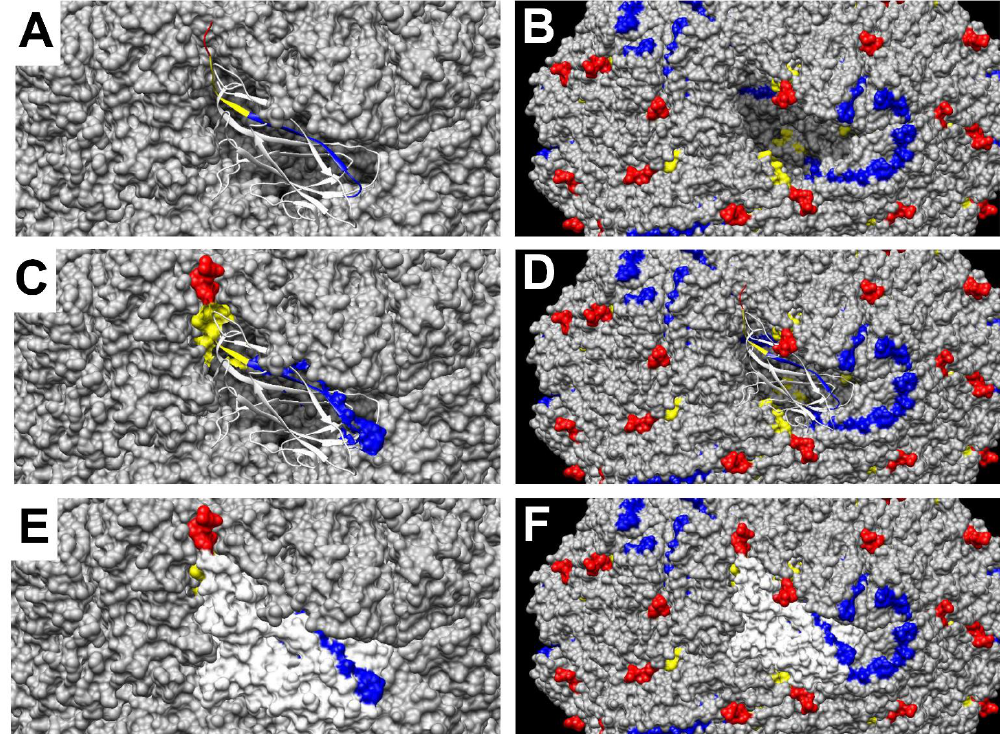
Figure 3. Location of amino acid residues of designed peptide (P64) and critical binding residues on the capsid protein of PCV2a. ( A ) The secondary structures of the single capsid protein of PCV2a were represented as a ribbon diagram in one VLP of PCV2a. The residues 228 – 231 were highlighted in red, the residues 220 – 227 were labeled in yellow, and other residues 205 – 219 were labeled in blue ( A – F ). These color residues represented the peptide P64. ( B ) The VLP of PCV2a lacks a single capsid protein subunit. ( C ) 3-D model of the peptide P64 rendered as a solid surface. ( D ) The secondary structure of the single capsid protein is represented as a ribbon diagram in one VLP. ( E ) 3-D model of the single capsid protein subunit rendered as a solid surface. ( F ) The surface map of all capsid proteins subunits in one VLP. The structural model of the capsid protein and the VLP of PCV2a coordinates were retrieved from the Protein Data Bank (PDB) entries for the capsid protein of PCV2a (PDB code: 3JCI) [54], and images were generated using UCSF Chimera version 1.14 from the Resource